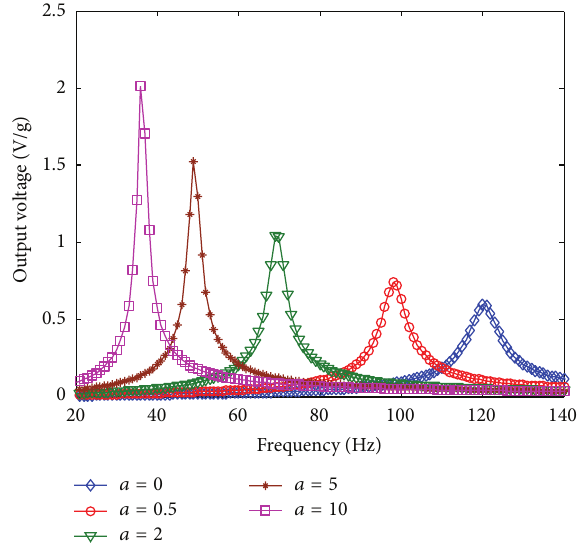
Figure 6: Output voltage for the PVEH with various mass ratios 𝑎 when 𝑅 𝐿 = 1 k Ω .